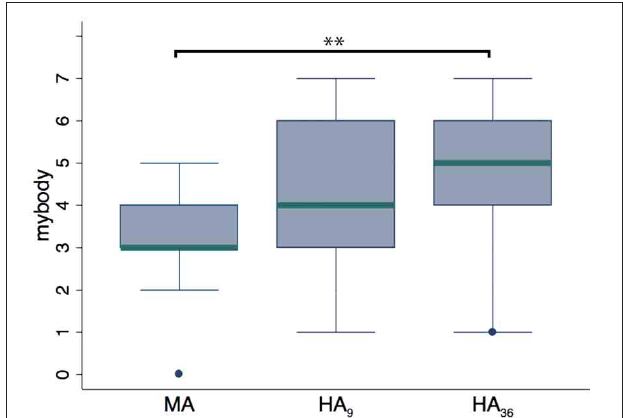
FIGURE 6 | Questionnaire data from experiment 3, in which we compared two groups that had different virtual bodies. Mannequin appearance: MA (9 subjects); human appearance: HA 9 (9 subjects) and HA 36 (36 subjects, where all the human appearance conditions in the 1PP were grouped together irrespectively of the visuotactile and head tracking